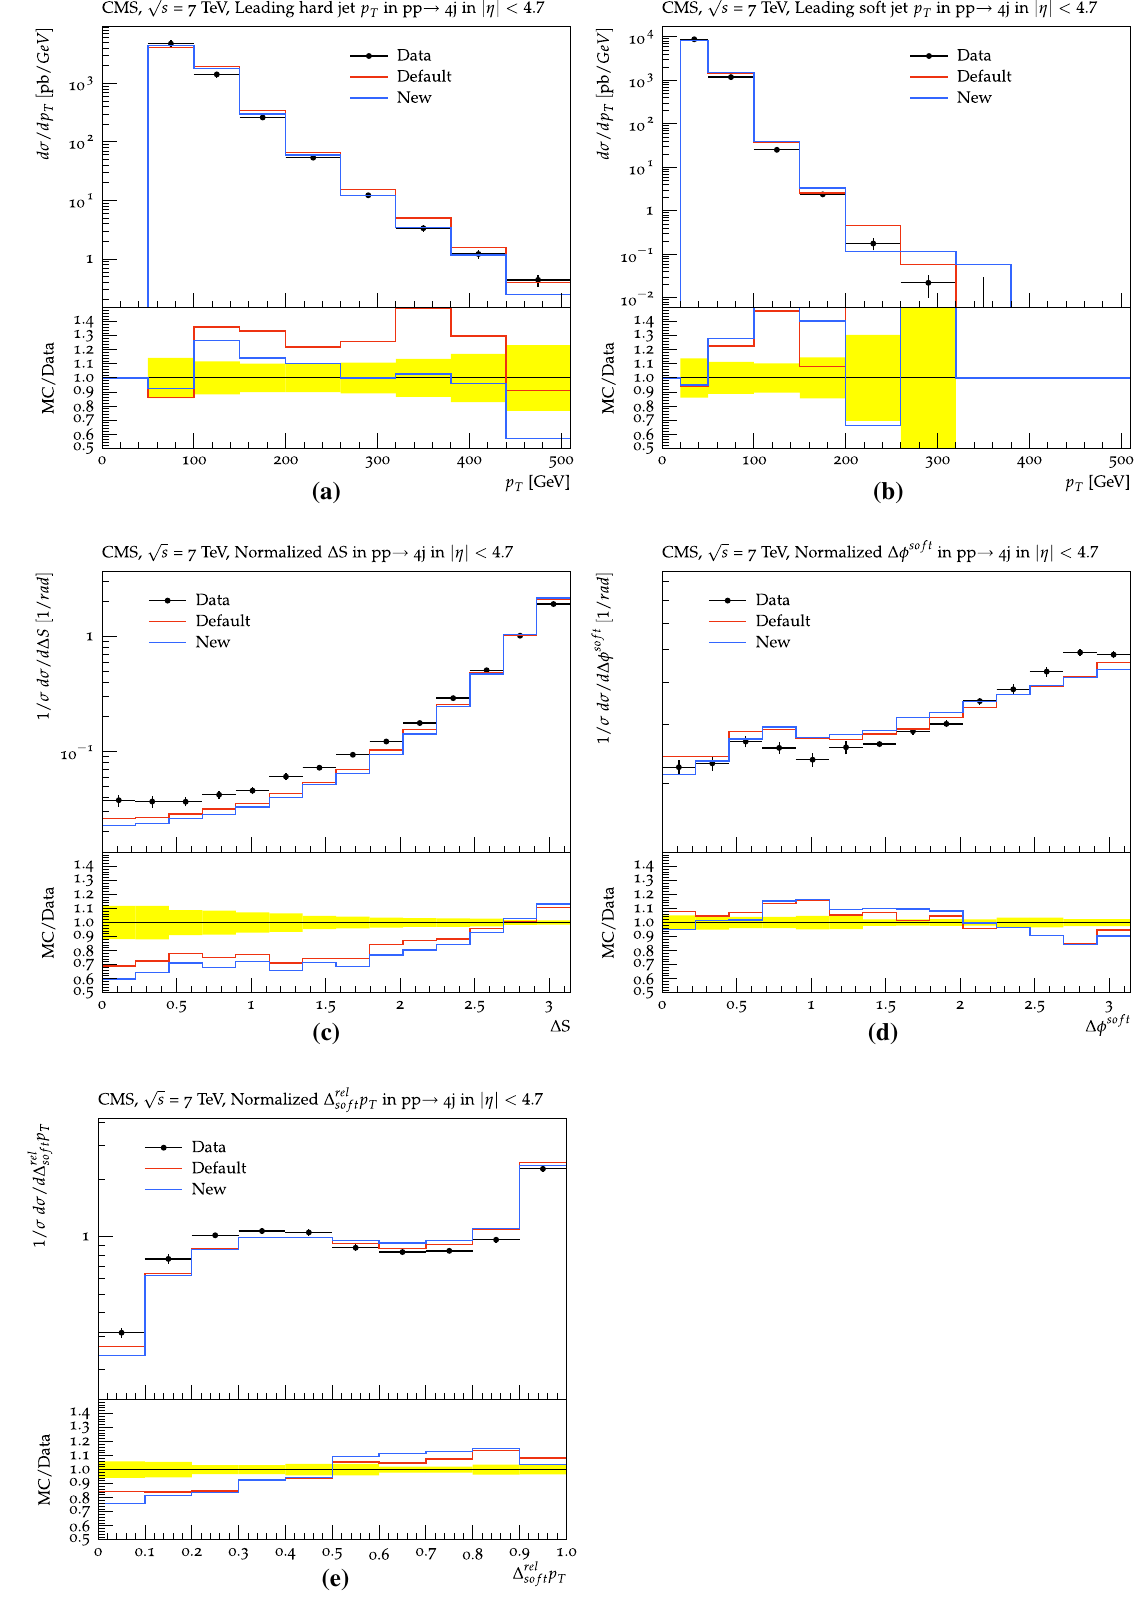
Fig. 15 Four-jet cross-sections measured by CMS for pp collisions at 7 TeV [44,52], as a function of several observables defined in